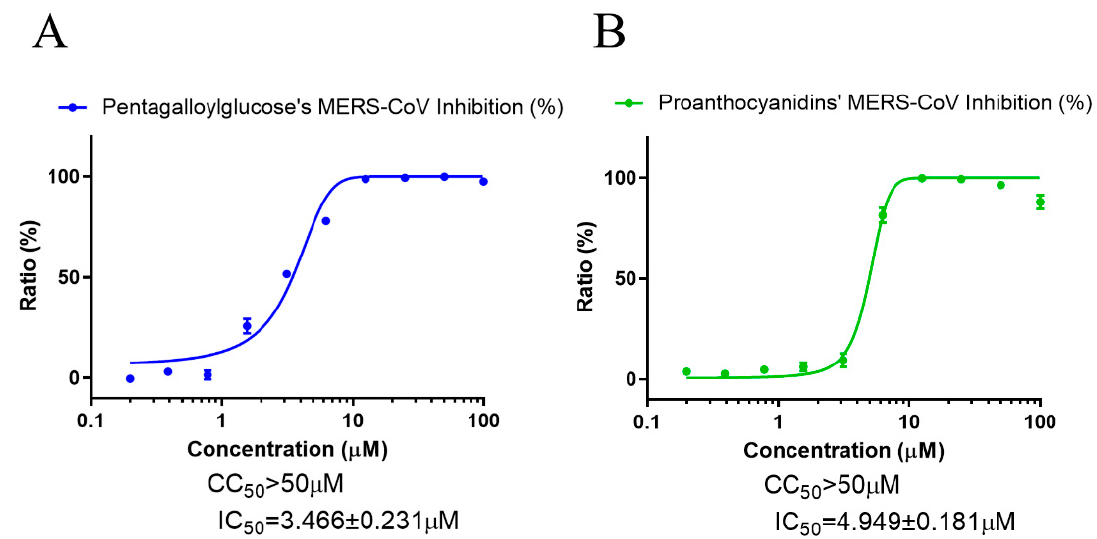
Figure 6. Anti-MERS-CoV activity of PGG and PAC. ( A ) The dose–response curve analysis using the immunofluorescence-based antiviral assays showed the antiviral effect of PGG ( A ) and PAC ( B ) on the MERS-CoV infection in Vero cells. Blue circles ( A ) and green circles ( B ) indicate the inhibition percentage of the MERS-CoV infection by PGG and PAC, respectively. The data represent duplicate experiments, and are presented as the mean ± SEM.